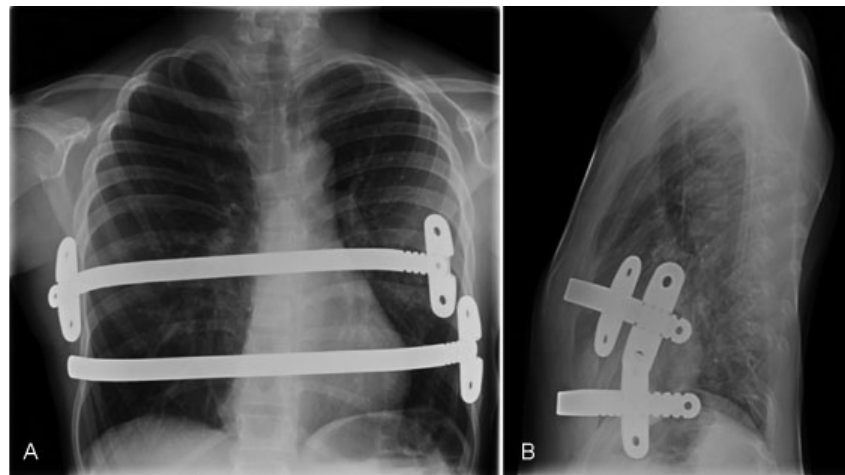
Fig. 3 Postoperative results X-ray. ( A ) Anteroposterior (AP) chest X-ray after Nuss procedure. ( B ) Lateral chest X-ray after Nuss procedure. (c) AP chest X-ray after Nuss bar removal 2 years after placement.